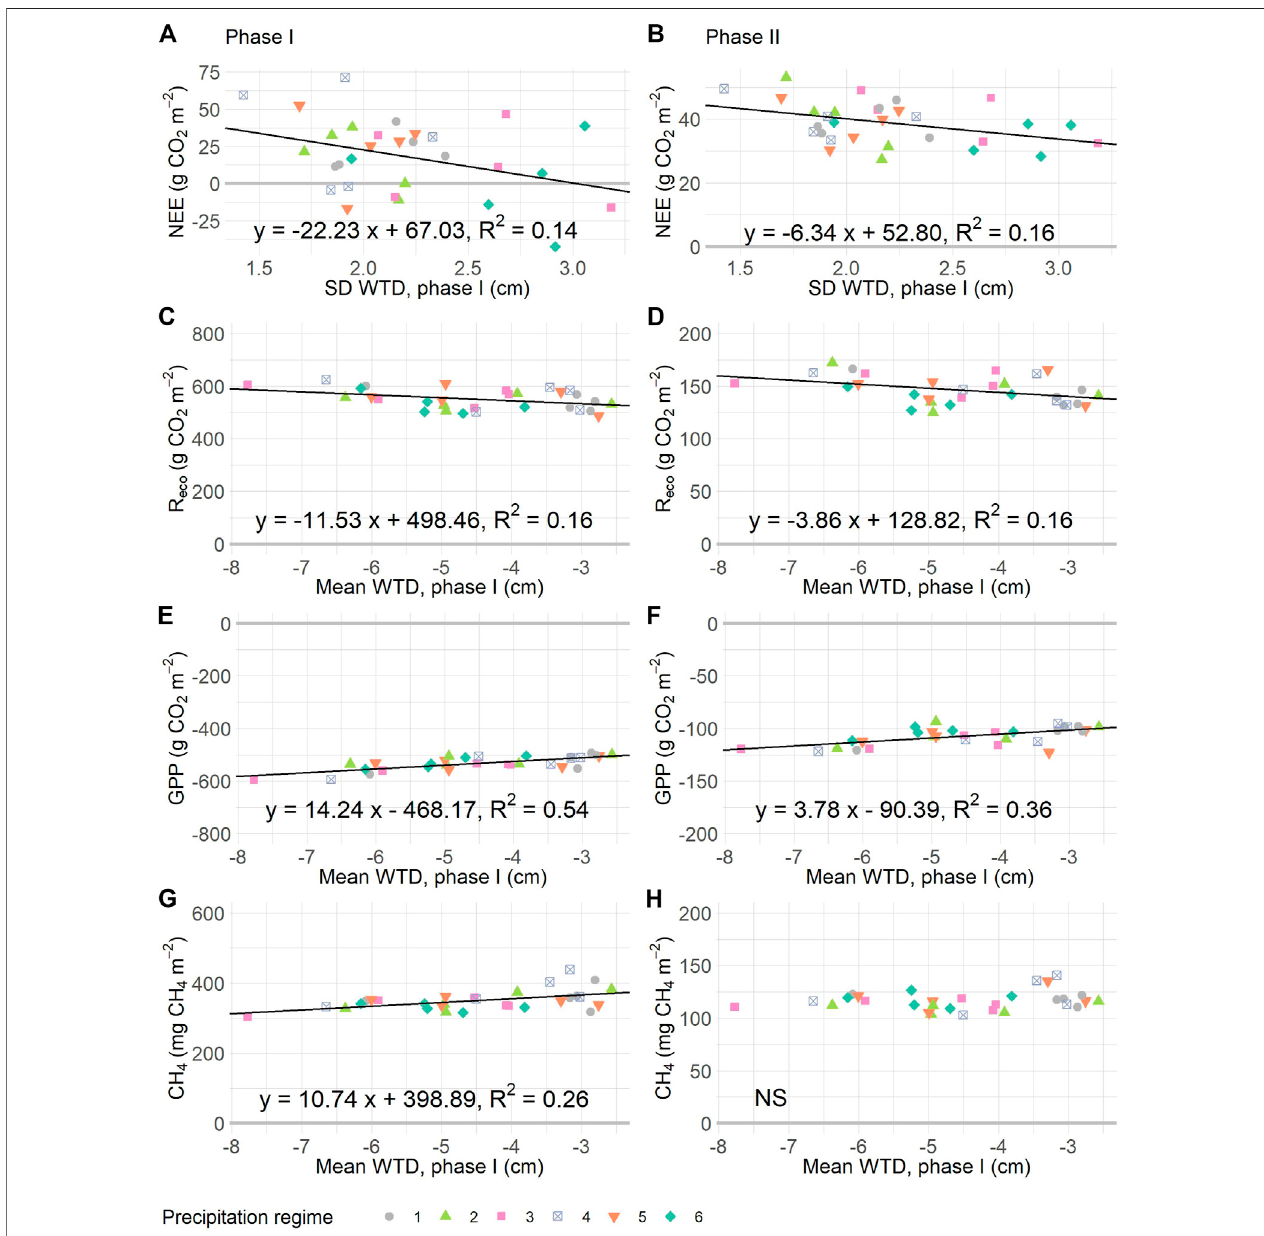
FIGURE 6 | Relationships between cumulative gas fl uxes during the resistance (I, panels A , C , E , G ) and resilience (II, panels B , D , F , H ) phases, and the WTD dynamics of the resistance phase. Panels (A) , (B) : net ecosystem exchange (NEE) is explained by the standard deviation water table depth (SD WTD). In (C) , (D) ecosystem respiration (R eco ) is plotted against WTD mean, as are gross primary production (GPP, in E and F ) and methane (CH 4 , in G and H ). Drawn relationships are signi fi cant at p < 0.05, based on linear regressions given in Table 3 . For details on precipitation regimes, please see Figure 1 .